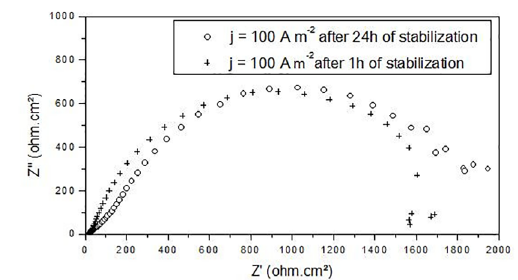
Figure 8. Nyquist diagram of the Cu-Sn coating obtained using j = 100 A m -2 after 1h and 24h of immersion in NaCl 0.5 mol L -1 .